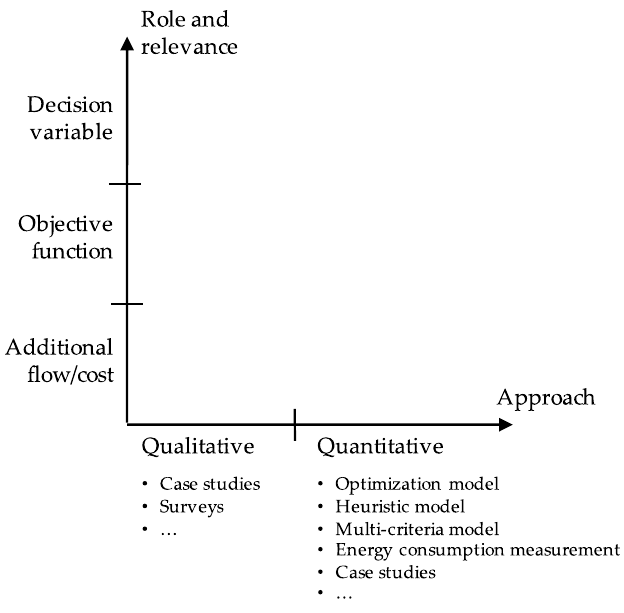
Figure 4. Classification scheme.